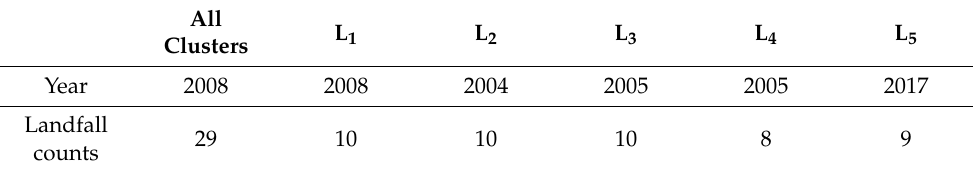
Table 5. TC season of maximum landfalling frequency for whole basin and each